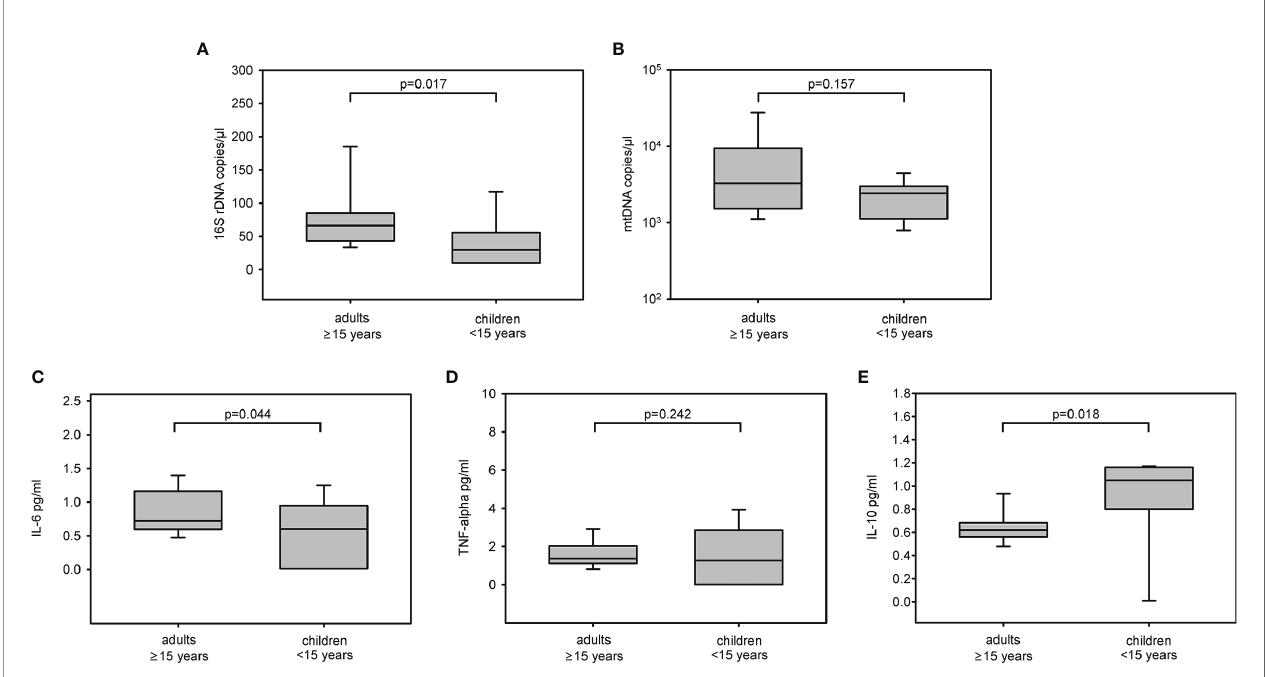
FIGURE 2 | Circulating markers of PAMPs, DAMPs, and in fl ammatory cytokines in COVID-19 subjects at fi rst sampling. 16S rDNA (A) , mtDNA (B) , IL-6 (C) , TNF- a (D) and IL-10 (E) levels in COVID-19 patients among age classes at 2.8 (2.1 – 3.7) months after baseline.